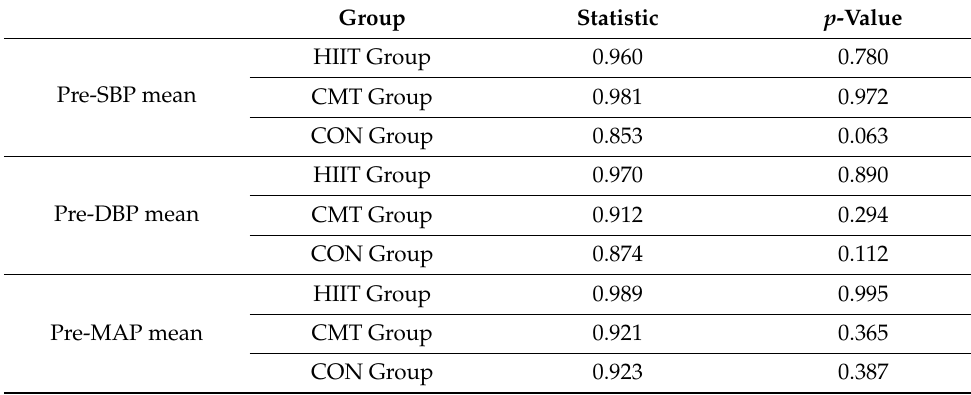
Table 1. Test of normality at baseline for SBP, DBP and MAP among 3 groups.